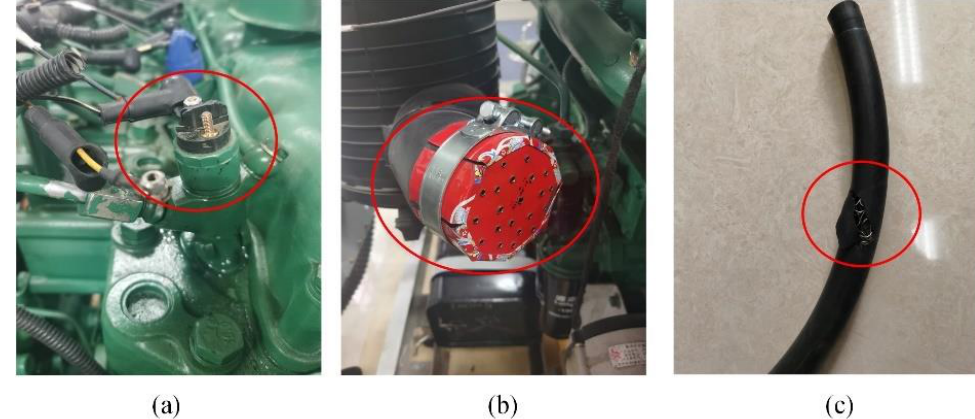
Table 1. The pre-set failure modes of the diesel engine.